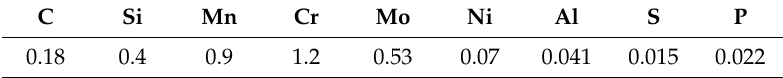
Table 1. Chemical composition (% mass) of G17CrMo5-5 cast steel according to PN-EN-10213-2.